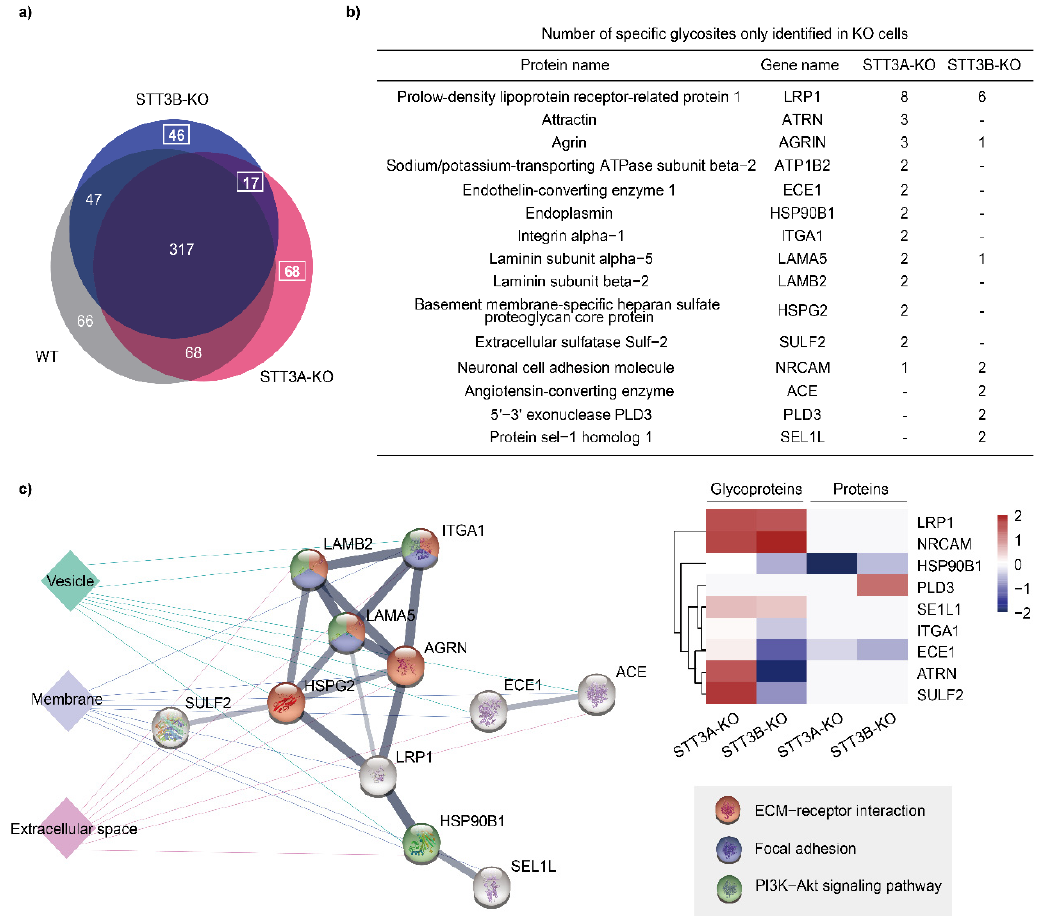
Figure 5. Hyperglycosylated proteins in STT3A-KO and STT3B-KO cells. ( a ) Venn diagrams of glycopeptides identified in WT and KO cells. ( b ) Proteins with at least two additional glycosites in KO cells are listed. Numbers represent the additional glycosites on the proteins observed in STT3A-KO and STT3B-KO cells. ( c ) The protein–protein interaction (PPI) network and cellular localization of hyperglycosylated proteins (left), and their relative abundance in proteins and glycoproteins in KO cells compared with WT cells (right). The thickness of the lines in the PPI represents the strength of the correlation, and the colors indicate different intracellular localizations and pathways .